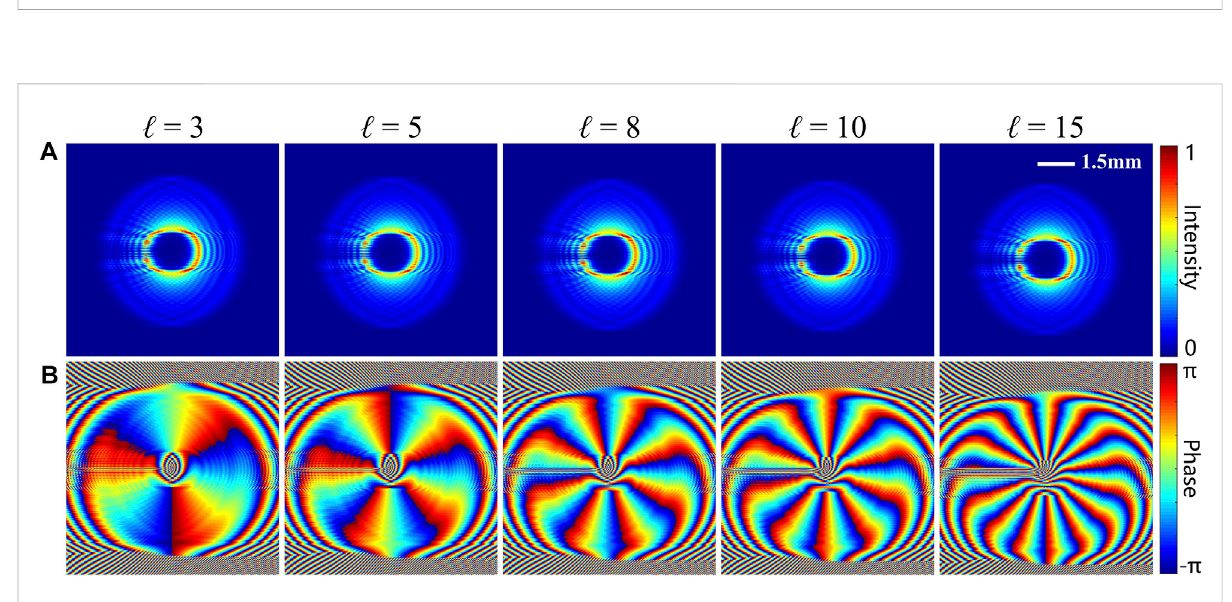
FIGURE 3 Intensity (A) and phase (B) distribution of the generated vortex beams by setting the topological charge ℓ = 3, 5, 8, 10, and